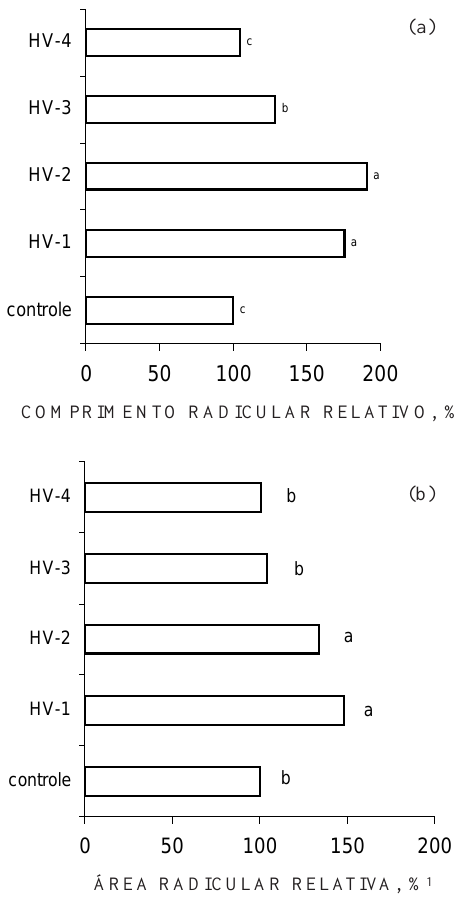
Figura 2. Incremento na área radicular (a) e no comprimento total de raízes (b) de plântulas de alface tratadas com 25 mg L -1 de C de humatos extraídos de vermicomposto de esterco de curral (HV1), de esterco de curral + bagaço de cana de açúcar (HV2), de esterco de curral + folhas de leguminosas (HV3) e de esterco de curral + bagaço de cana de açúcar + folhas de leguminosas (HV4). Médias seguidas de mesma letra não diferem significativamente pelo teste de Tukey (P <